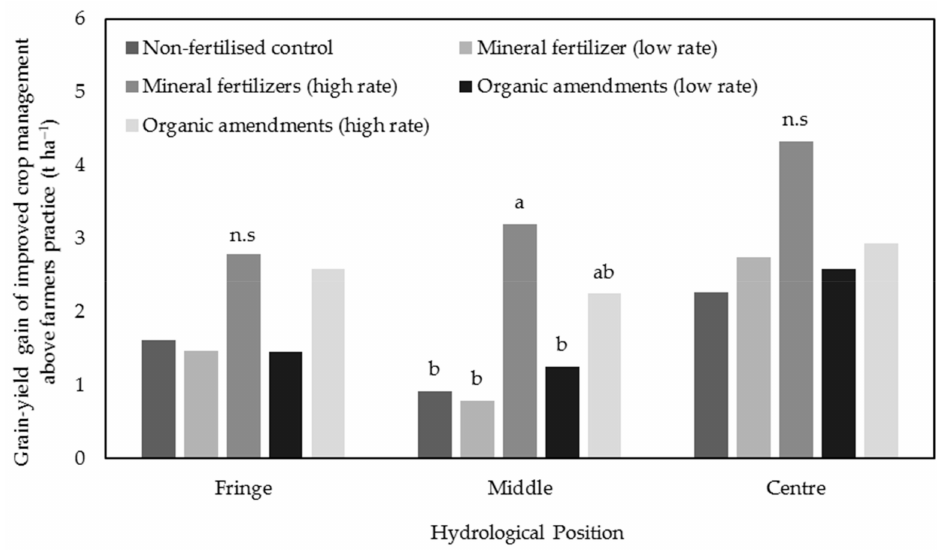
Figure 6. Grain yield gain of improved crop management above the farmer’s practice at di ff erent hydrological positions.